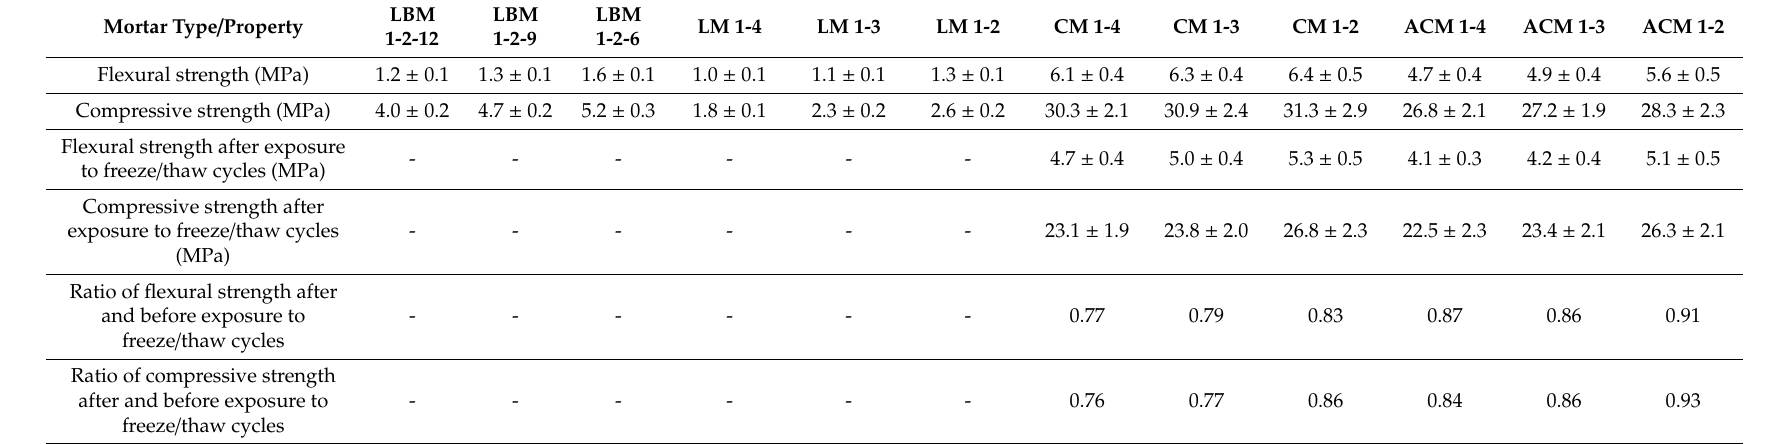
Table 3. Properties of mortar specimens prior and after their exposure to freeze / thaw cycles with the corresponding standard